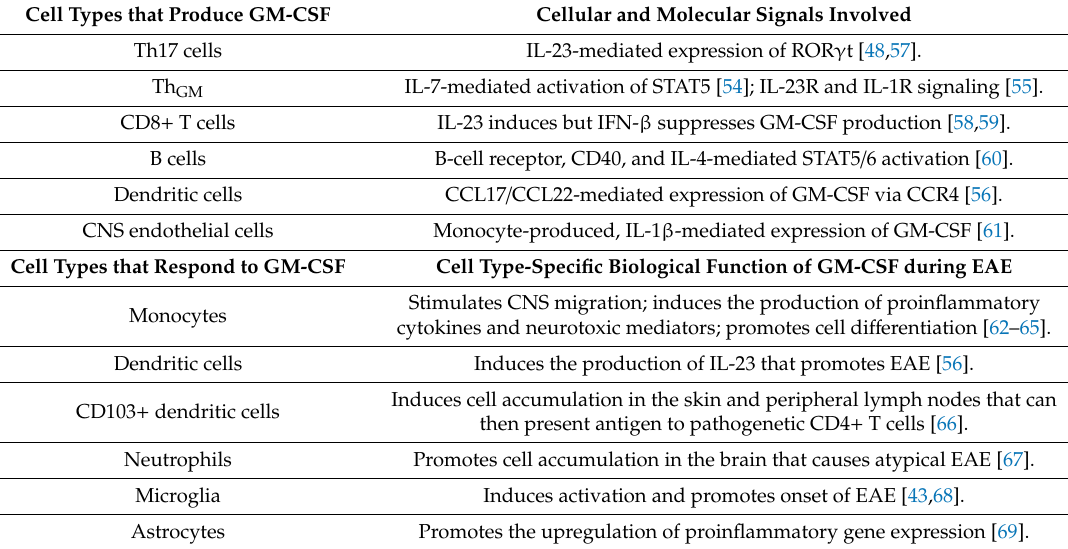
Table 1. Immune cell types that produce or respond to GM-CSF during